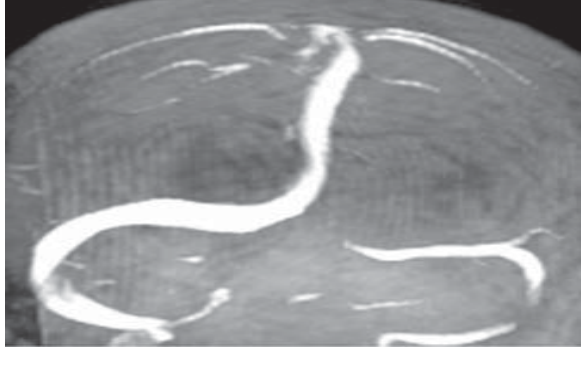
Figure 5. Flow gap in non-dominant left transverse sinus Inferior sagittal sinus (ISS) was observed in 11% cases. Internal cerebral vein(ICV) was seen in 60 cases. An occipital sinus was observed in 4% of the cases (Figure 6).